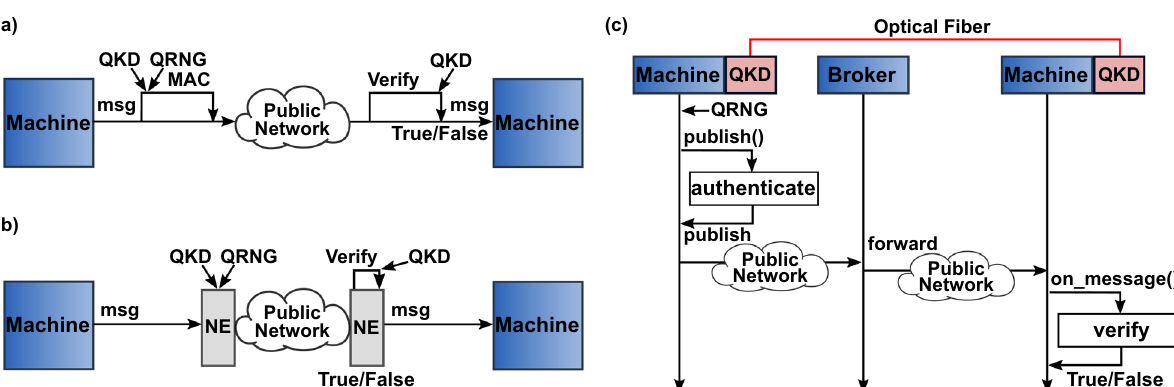
Figure 2. Showing (one-way for simplicity) generalized authentication approach using QKD secret keys and QRNG that can be implemented in: ( a ) Open-source and ( b ) Proprietary SCADA communication protocols to authenticate outgoing messages by one machine and verify incoming messages by another. ( c ) Implementation of the authentication approach using QKD secret keys and QRNG in the MQTT publisher/subscriber protocol operating for SCADA communications. MAC: Message authentication code. msg: SCADA message. NE: Network encryption card. on_message(): MQTT specific on received message callback function. publish(): MQTT specific on publish message callback function. QKD: Quantum key distribution. QRNG: Quantum random number